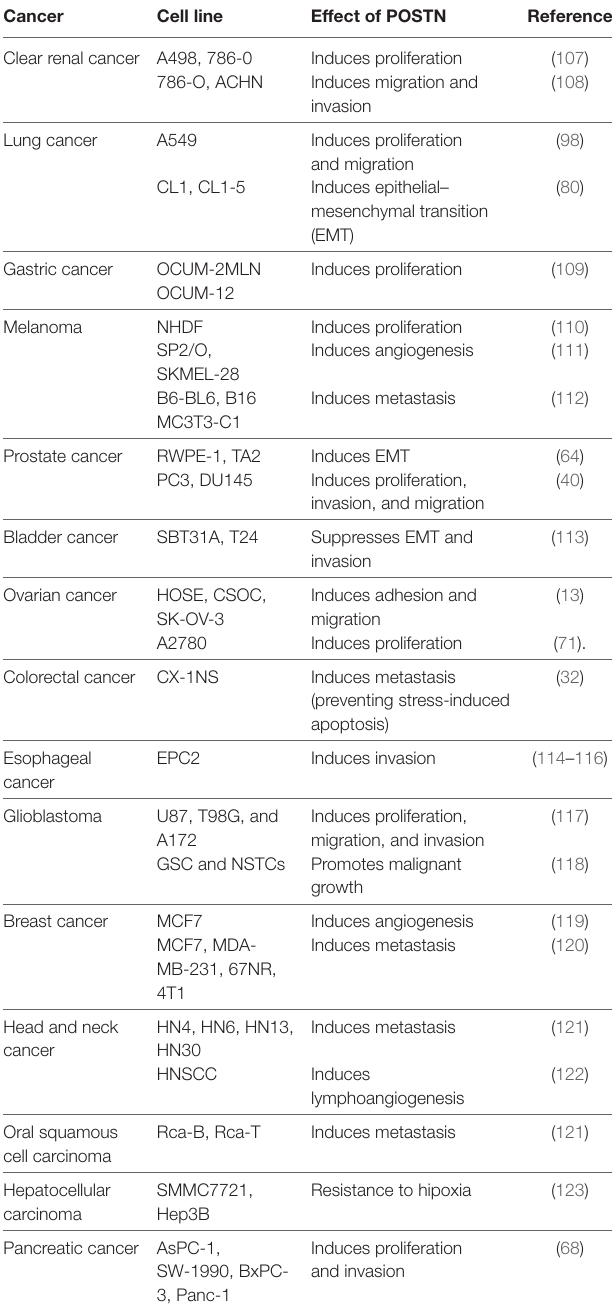
TAbLe 4 | Effect of periostin (POSTN) on tumor cells.